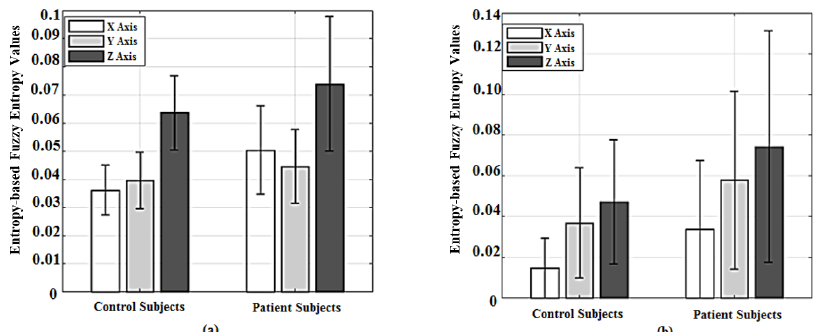
Figure 6. Bar-graphs represent mean and standard deviation values of velocity-based Fuzzy entropy values of Trunk test, whereas ( a ) is Sensor 1 and ( b ) is Sensor